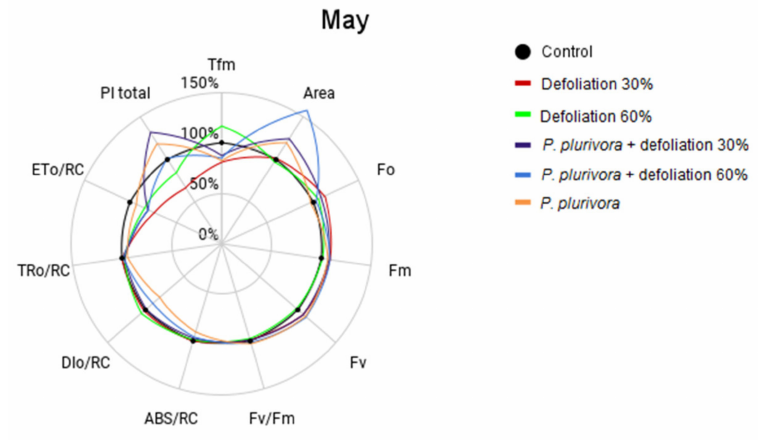
Figure 3. Comparison of chlorophyll fluorescence parameters in different treatments in May. Param- eters: PI total—the total performance index of photosystem II, Tfm—the time at which the maximum fluorescence value was reached, Fo—the initial fluorescence representing the emission by excited chlorophyll molecules in the antenna structure of the photosystem II, Fm—the maximum fluorescence value, Fv—variable fluorescence, Fv/Fm—maximum photochemical quantum yield of PSII, Area— the area across the fluorescence curve between Fo and Fm, ABS/RC—absorption flux of antenna Chls per RC (RC—reaction center), TR0/RC—trapped energy flux per RC, ET0/RC—electron transport flux per RC, DI0/RC—total energy dissipated per reaction center.